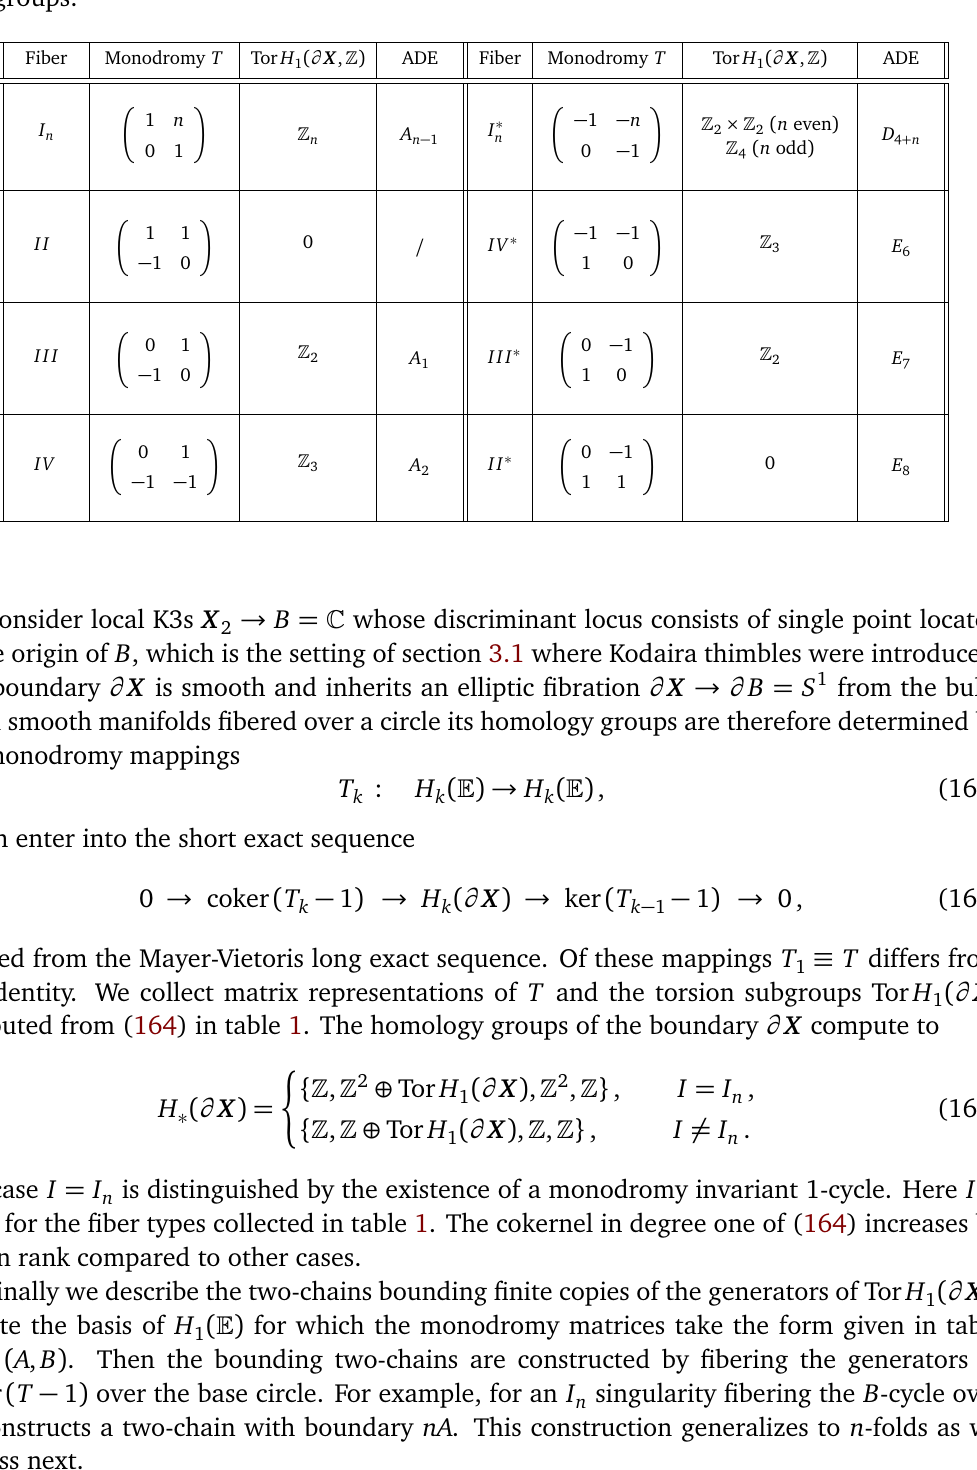
Table 1: Kodaira’s classification of singular fibers, monodromies and torsion sub-